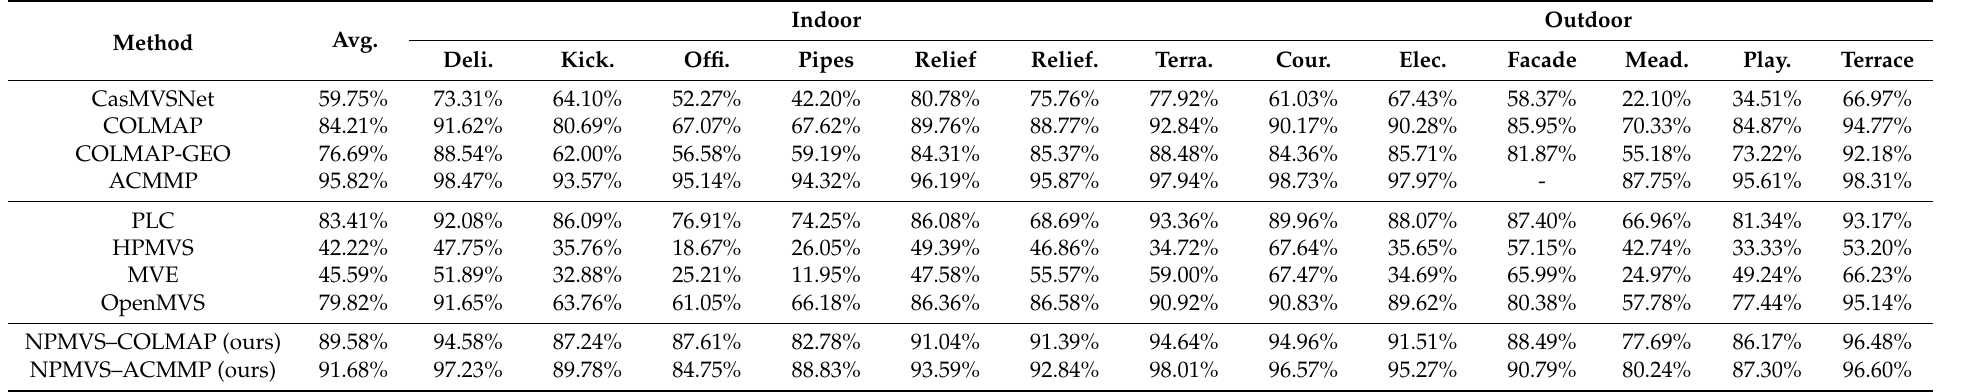
Table 4. Comparison of F1 score (higher is